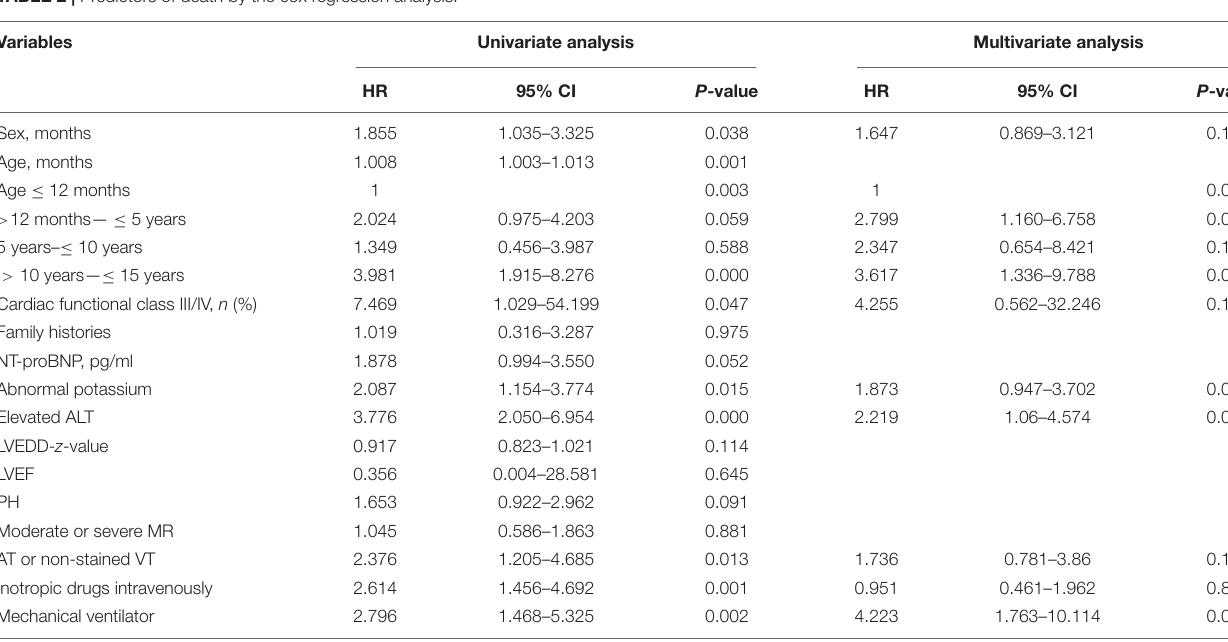
FIGURE 3 | Survival rates from Kaplan–Meier estimates among the study population by sex (A) and age at diagnosis (B) . TABLE 2 | Predictors of death by the cox regression